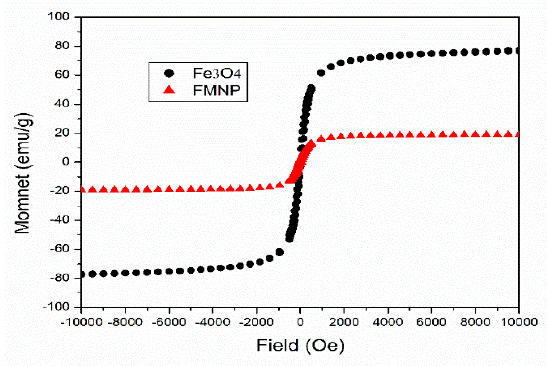
Figure 3. Hysteresis loops of Fe 3 O 4 NPs and core-shell FMNPs.